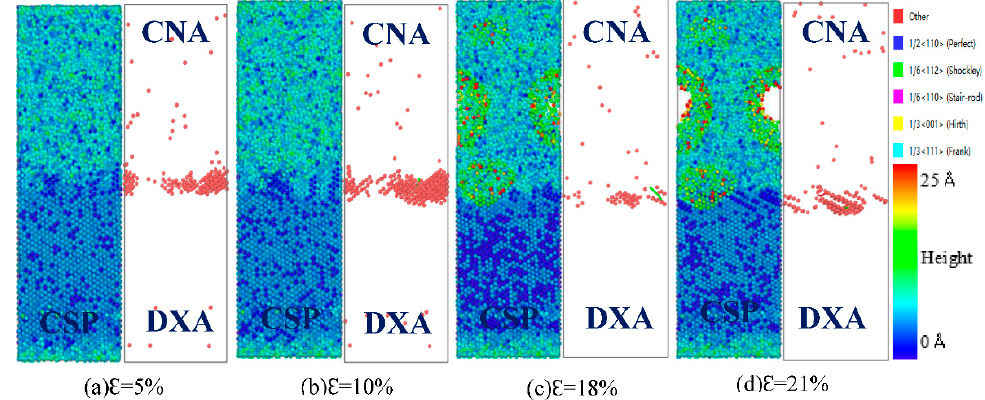
Figure 14. Atomic CSP, CNA, and DXA analysis of the Fe (110)/Cu (110) diffused interface under z-axis tensile process at 300 K.